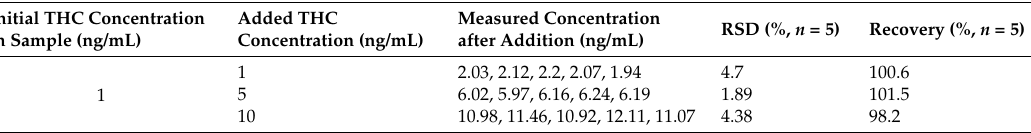
Figure 7. Specificity of the immunosensor to THC, THC + GSH, THC + Glu, THC + Salmonella , respectively. The concentration of THC, GSH, Glu, and Salmonella is 1 ng/mL, 1 ng/mL, 1 ng/mL, 1 × 10 3 cfu/mL. Error bars represent percent of data 5%. Table 2. Determination of THC in rat serum sample.